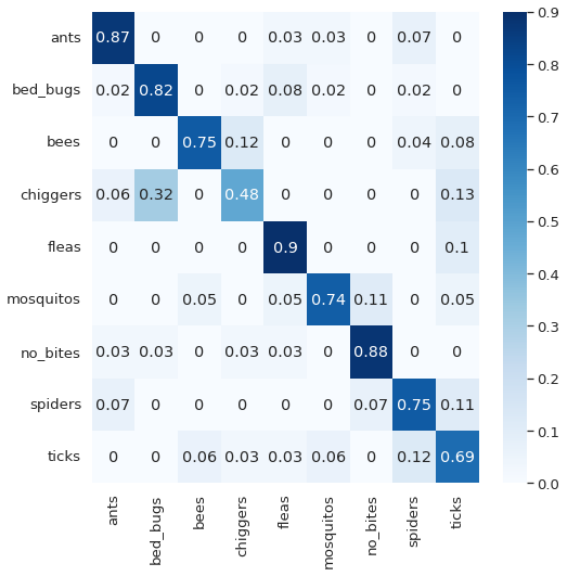
Figure 12. Normalized confusion matrix for